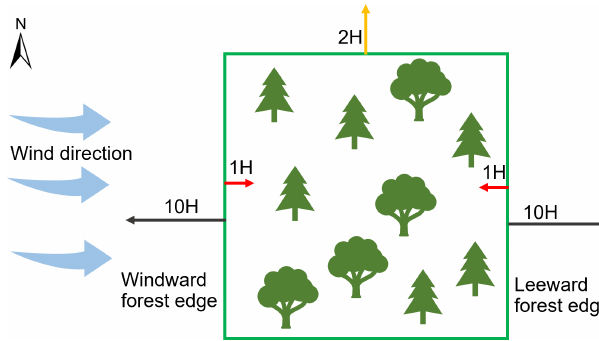
Figure 3. Graphical illustration of forest edges and respective max- imum search distances, d max . 10 H indicates the maximum search distance in the open field from the forest edge in the windward and the leeward direction, 1 H indicates the maximum search distance in the forest from the forest edge in the windward and the leeward di- rection, and 2 H indicates the maximum search distance northward of the forest edge for shading